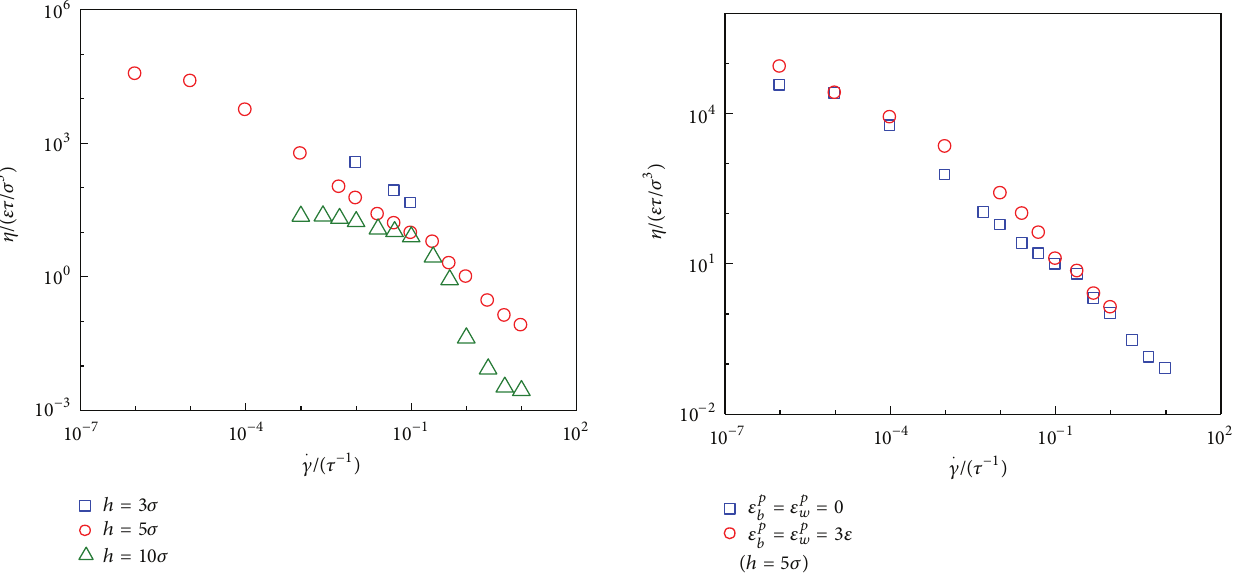
Figure 35: The shear viscosity of both nonfunctional ( 𝜀 𝑝 𝑏 = 𝜀 𝑝 𝑤 = 0 ) and functional ( 𝜀 𝑝 𝑏 = 𝜀 𝑝 𝑤 = 3𝜀 ) PFPE films confined between two solid surfaces with a separation of 5𝜎 and with 𝜀 𝑤 = 4𝜀 under 𝑇 = 1.0𝜀/𝑘 𝐵 .